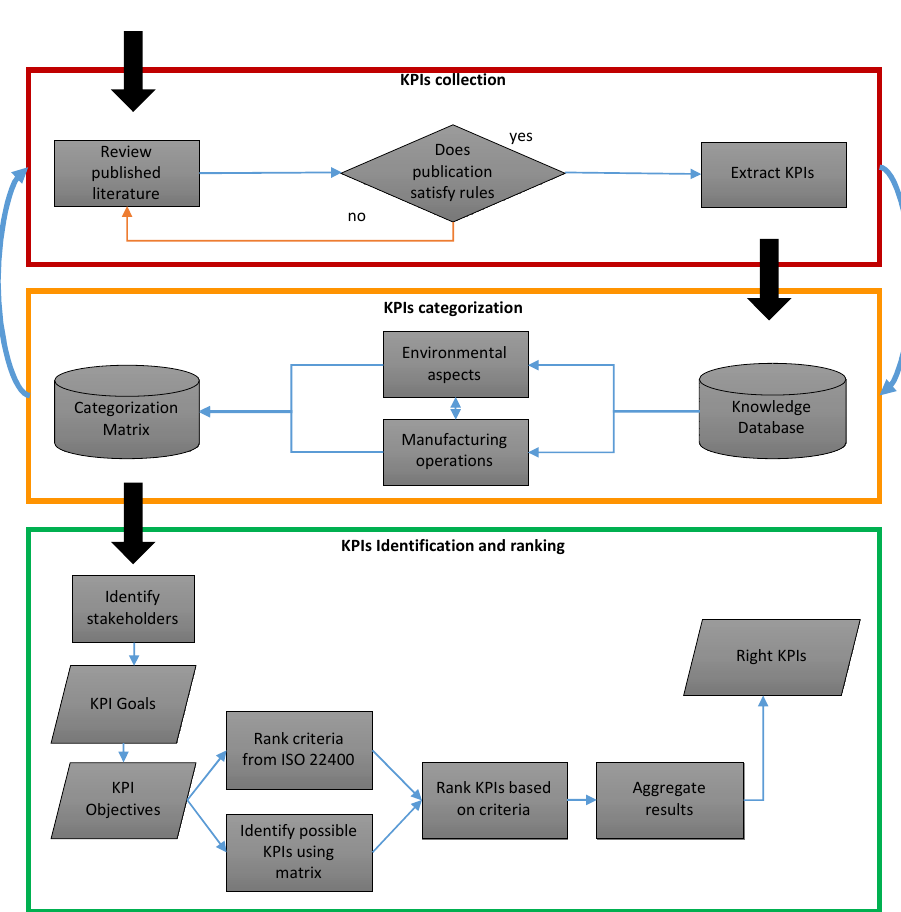
Figure 1. High-level schematic of the framework.